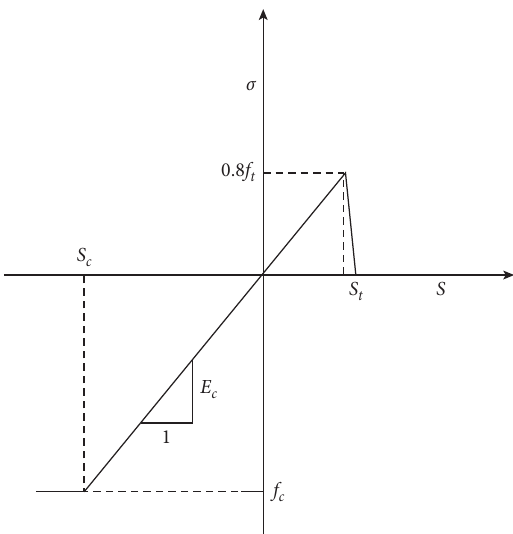
Figure 6: The normal force displacement of nonlinear